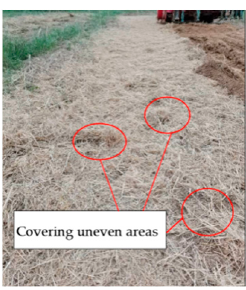
Figure 1. Working process of straw crushing, scattering, and sowing system.